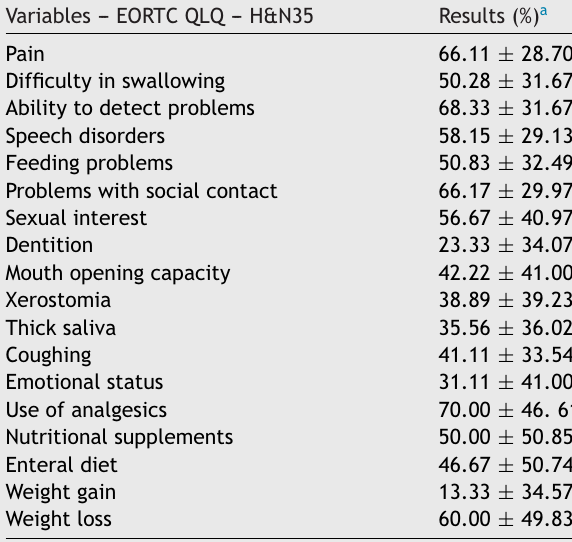
Basal values of EORTC QLQ --- H&N35 questionnaire for